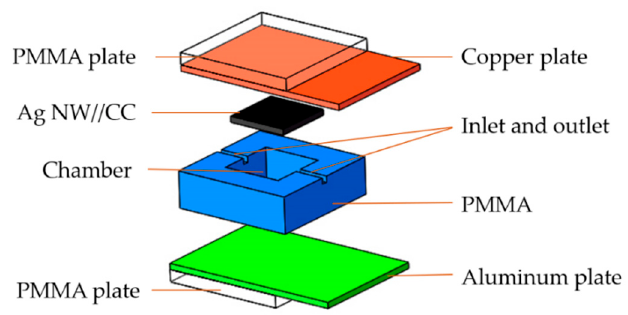
Figure 7. Schematic of the microfluidic Al-H 2 O 2 FC equipped with Ag NW//CC cathode.